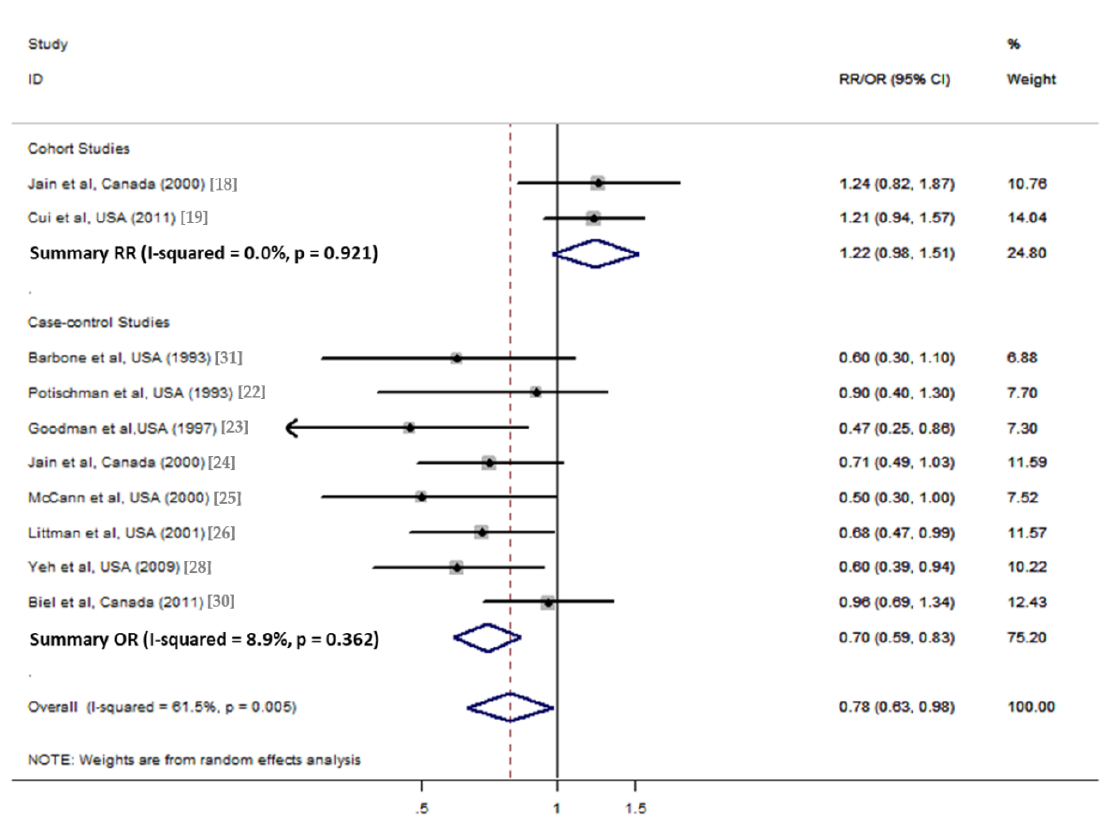
Figure 3. Funnel plot of the meta-analysis for the association between total dietary fiber intake and risk of endometrial cancer.